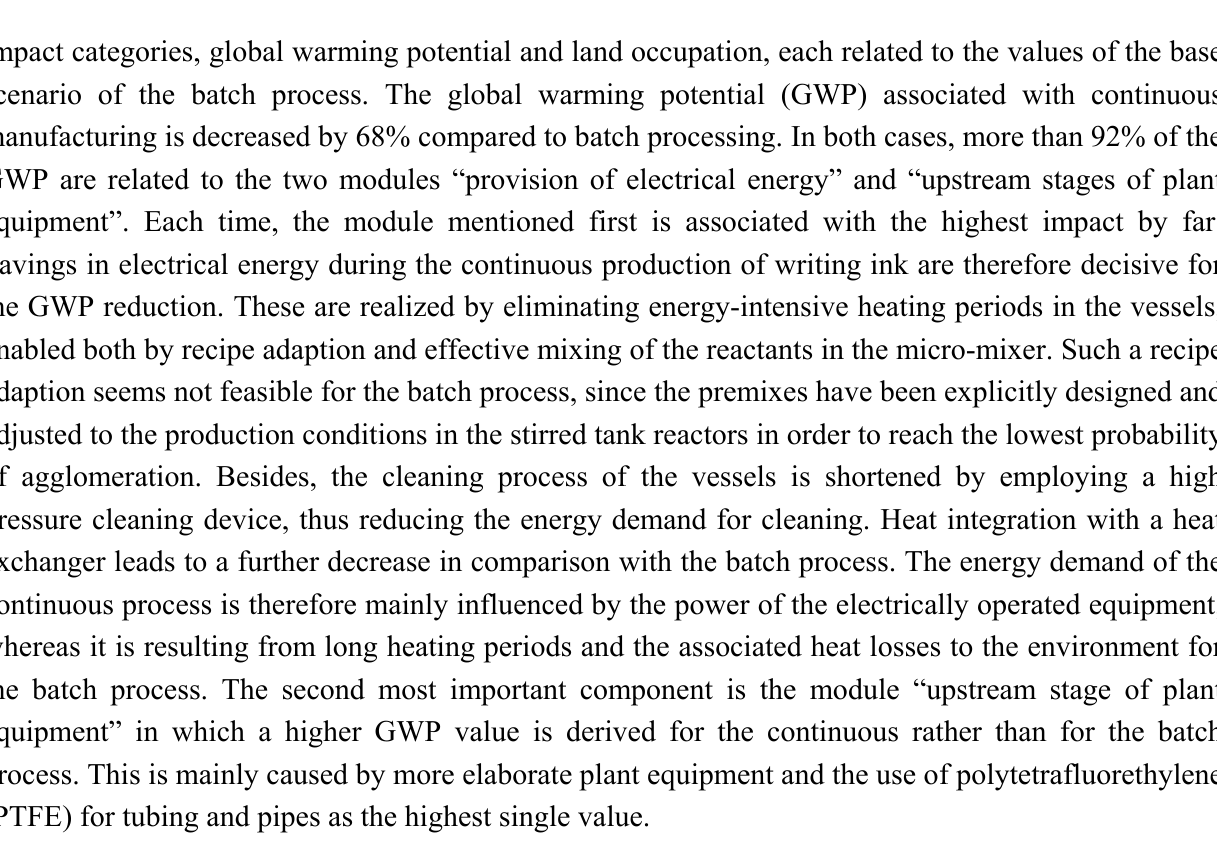
Figure 2. Comparison of the global warming potential (GWP) and land occupation (LO) of batch and micro-/milli-continuous campaign